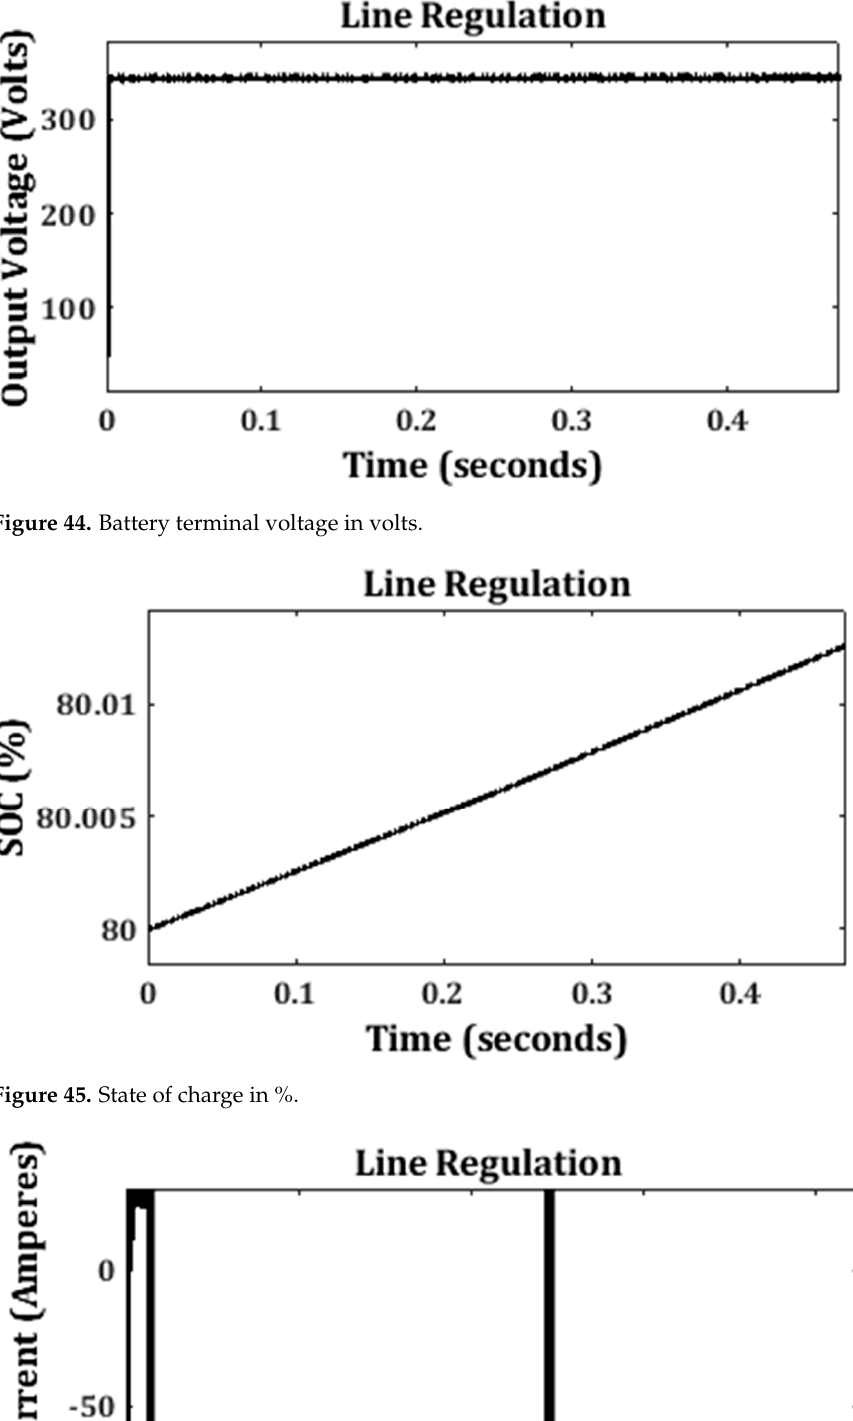
Figure 43. Input current in amperes during the line regulation.